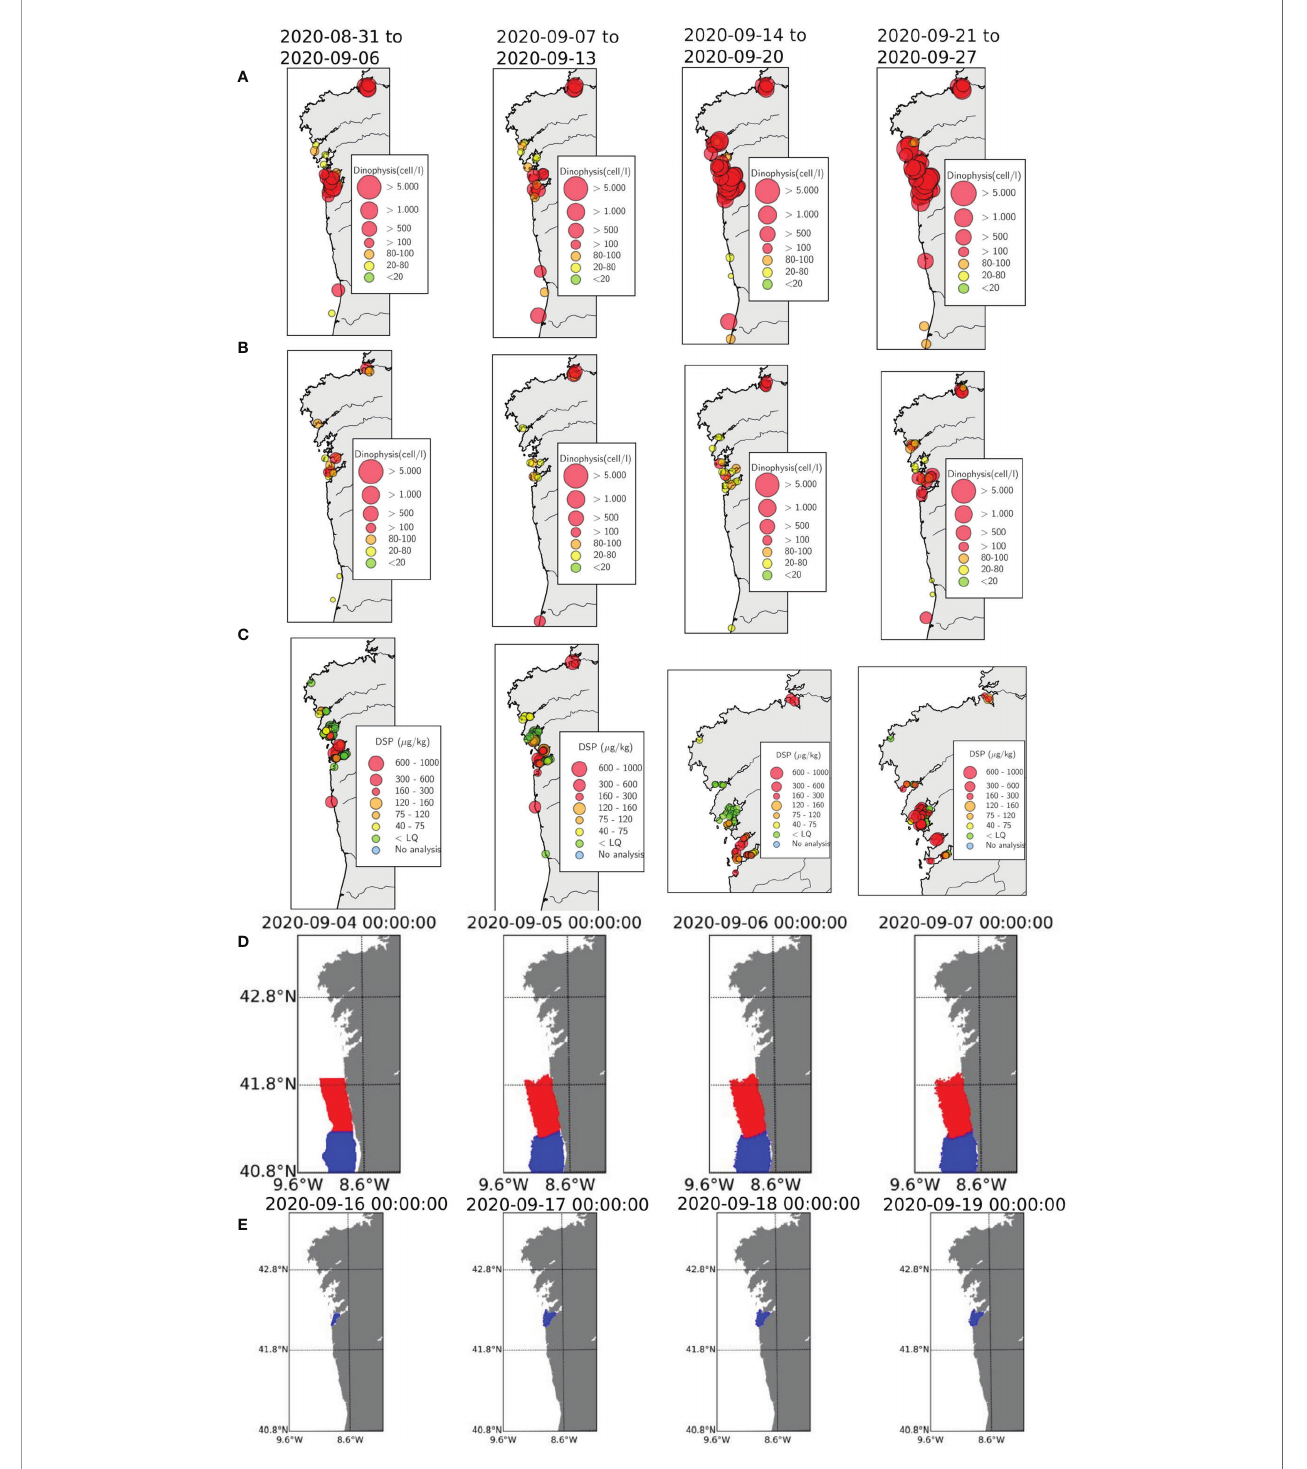
FIGURE 7 | Results of the PRIMROSE forecast and data from the weekly Galician and Portuguese monitoring programs in September 2020: (A) Dinophysis acuminata (B) Dinophysis acuta and (C) DSP toxins (no data available in Portugal during the last two weeks). (D) Particles released in Portuguese areas from 4-7 September (E) Particles released in the Ria de Vigo from 16-19